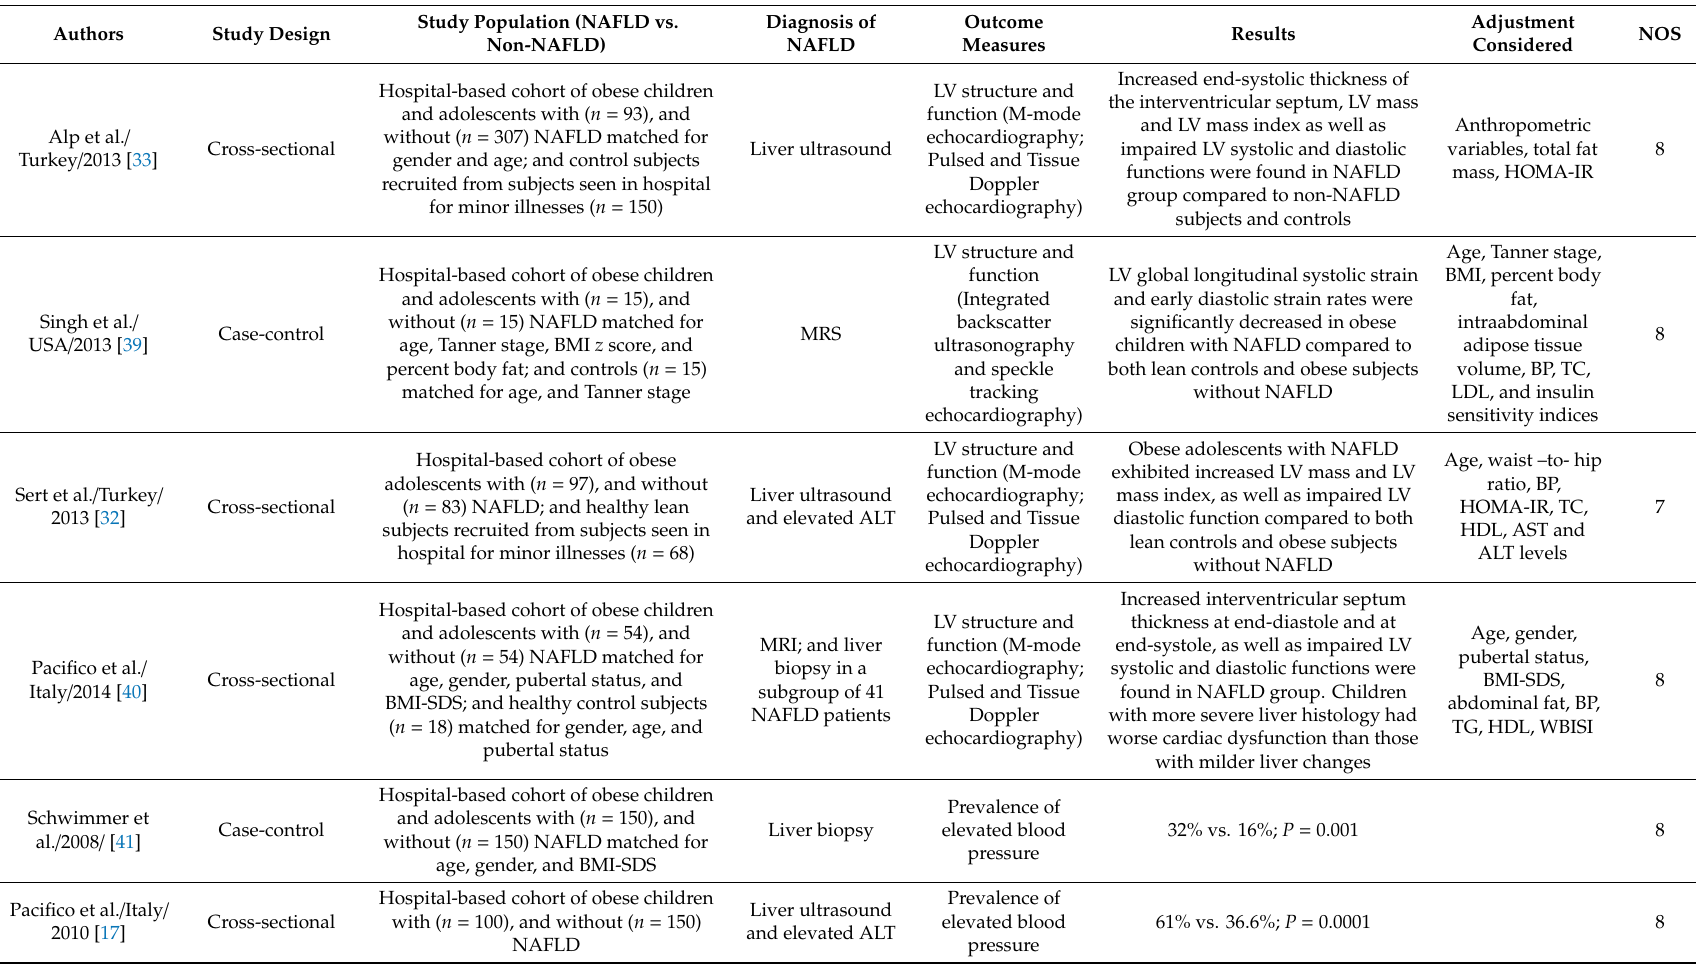
Table 2. Study characteristics for nonalcoholic fatty liver disease and cardiac structure and function alterations as well as